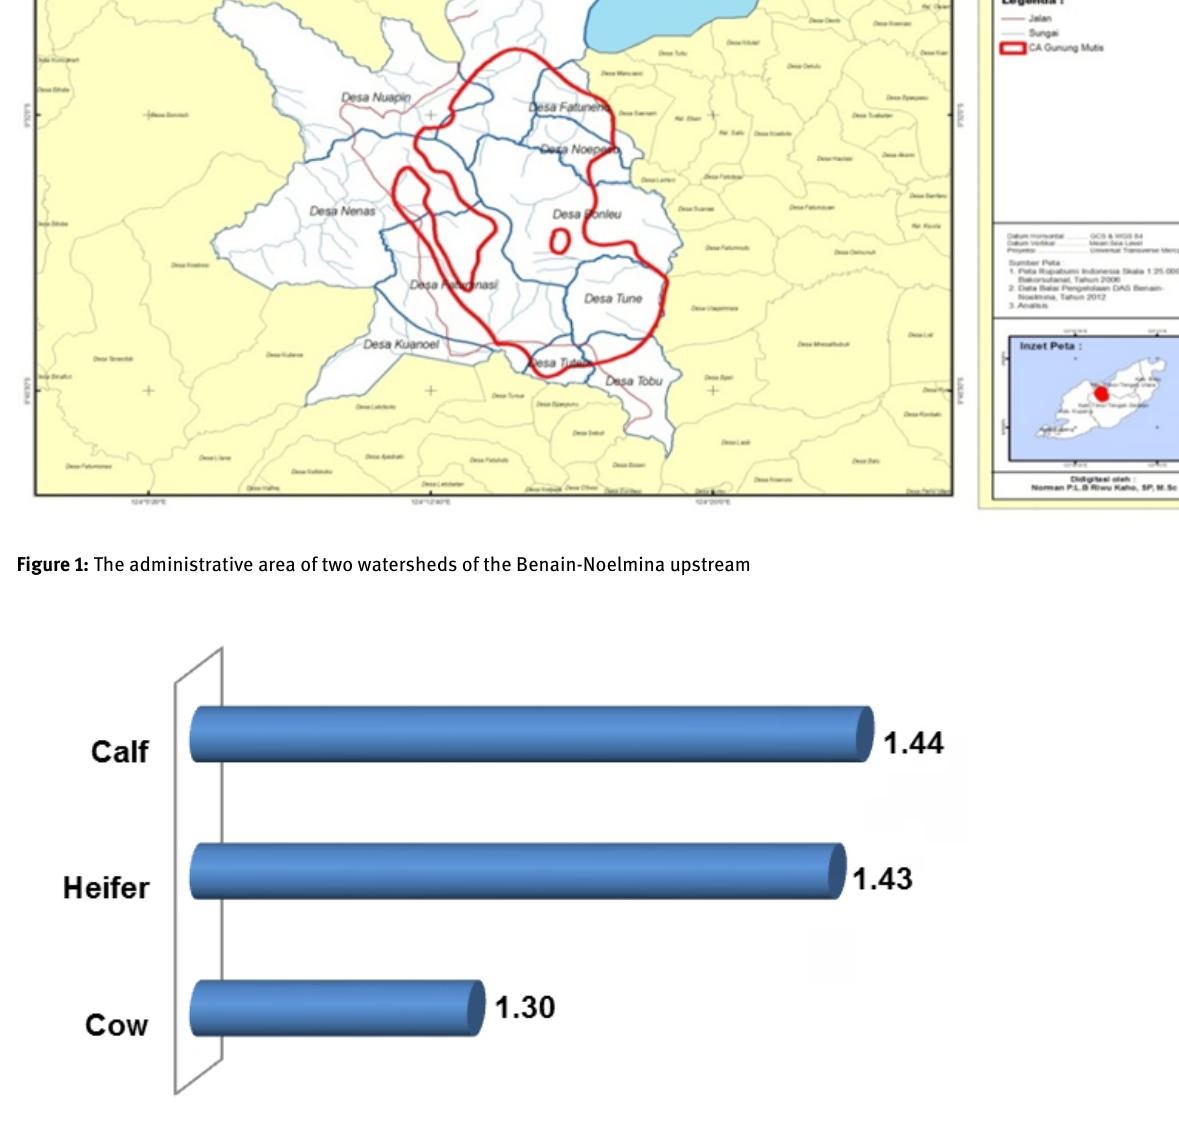
Figure 2: Average loss of beef cattle in the grazing system based on age